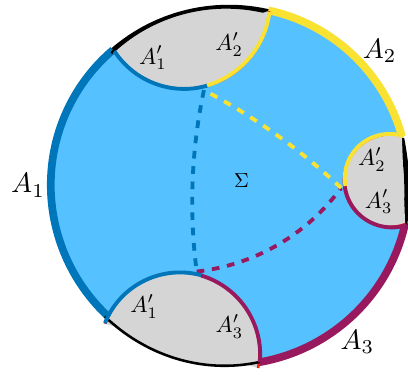
Figure 11 . The holographic multipartite EOP proposal of